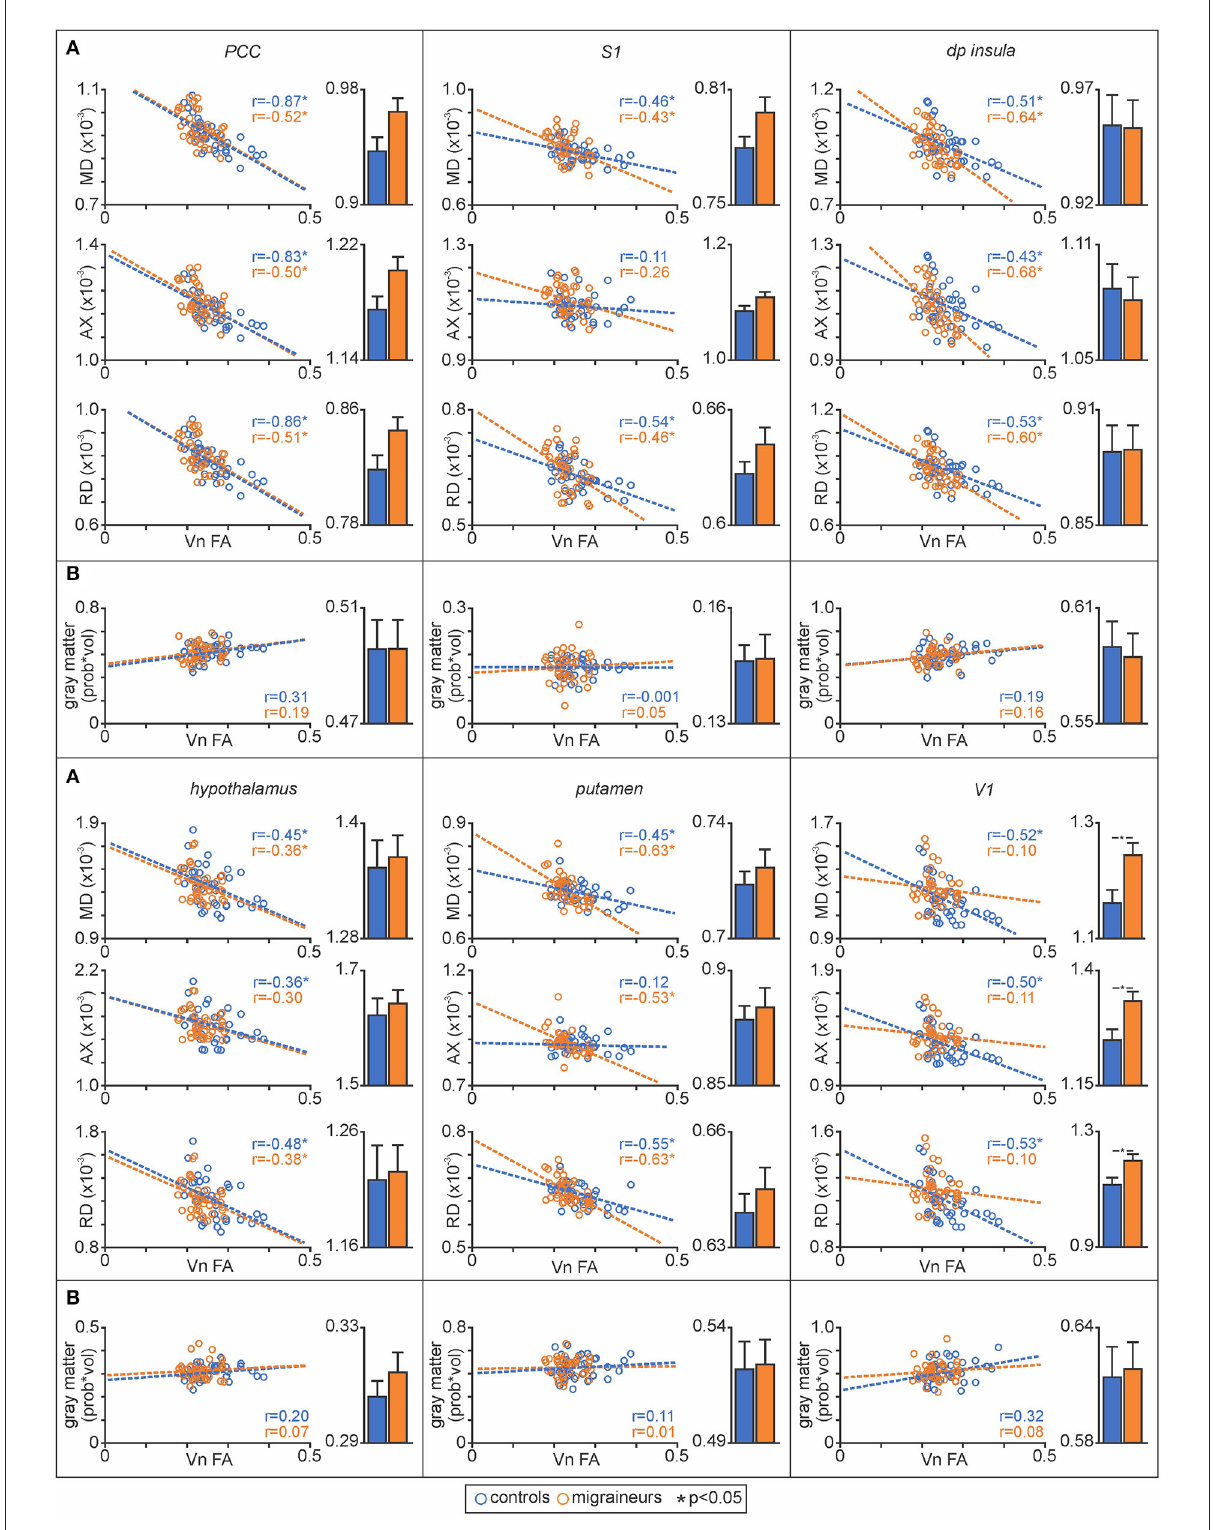
FIGURE5 (A) Plots of mean diffusivity (MD), axial diffusivity (AX) and radial diffusivity (RD) against trigeminal nerve fractional anisotropy (FA) for the posterior cingulate cortex (PCC), primary somatosensory cortex (S1), dorsoposterior insula (dp insula), hypothalamus, putamen and primary visual cortex (V1). In addition, to the right of each correlation plot are plots of mean ( ± SEM) MD, AX and RD values for each of the significant above the brainstem clusters. (B) Plots of gray matter volume against trigeminal nerve FA derived from significant MD clusters and plots of mean ( ± SEM) gray matter volume for each of the significant MD above the brainstem